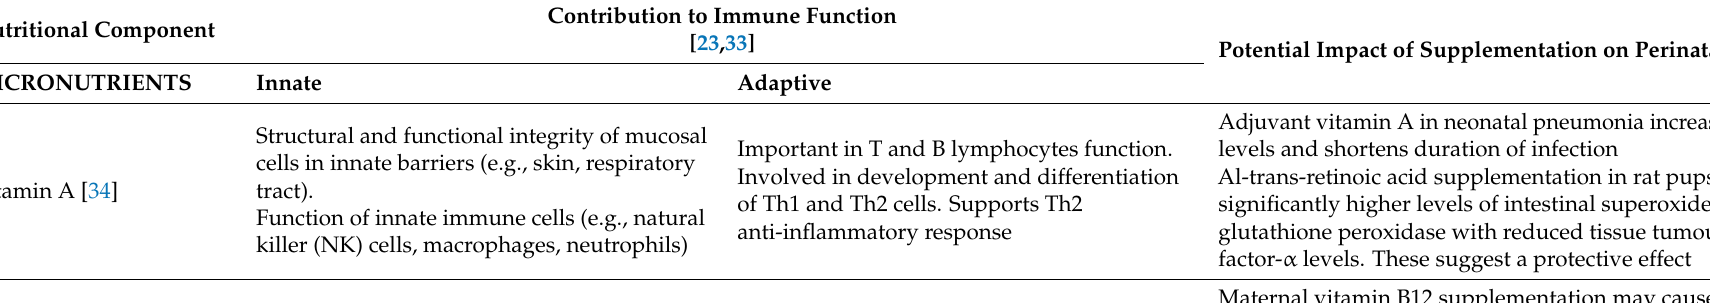
Table 1. Micronutrients and macronutrients: contribution to immune function, and potential impact of supplementation on perinatal